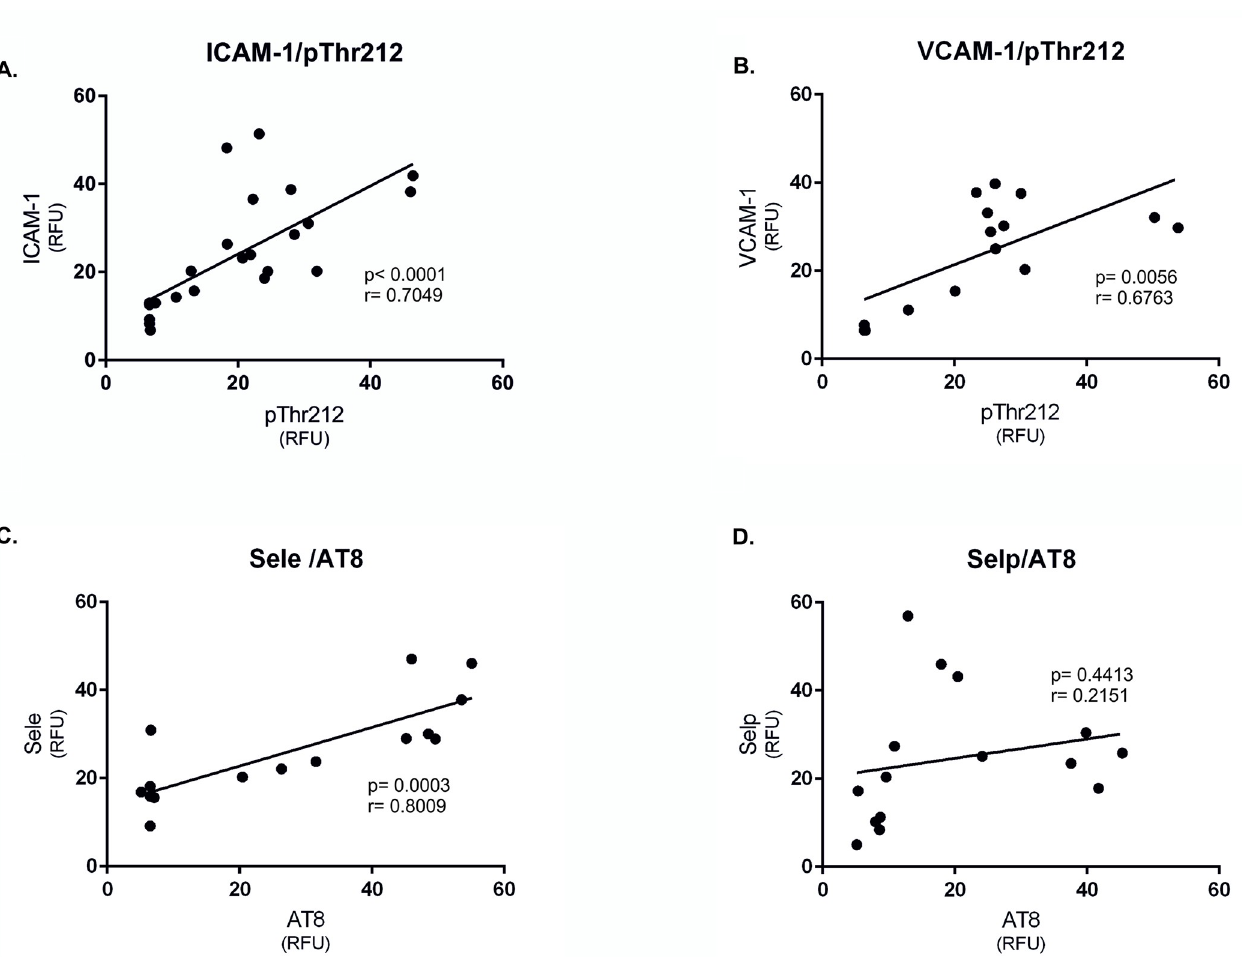
Fig 7. Expression of adhesions molecules correlates with the presence of neurofibrillary pathology. (A) Correlation between ICAM-1 immunoreactivity and the presence of neurofibrillary pathology (pThr212). (B) Correlation between VCAM-1 immunoreactivity and the presence of neurofibrillary pathology (pThr212). (C) Correlation between Sele immunoreactivity and neurofibrillary pathology (AT8) and (D) Selp immunoreactivity and neurofibrillary pathology (AT8).